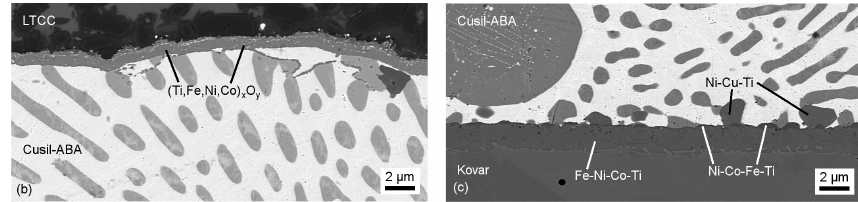
Figure 12. Enlarged SEM images of Fig. 10b showing the LTCC–Cusil-ABA (a) and the Kovar–Cusil-ABA interfaces (b) .